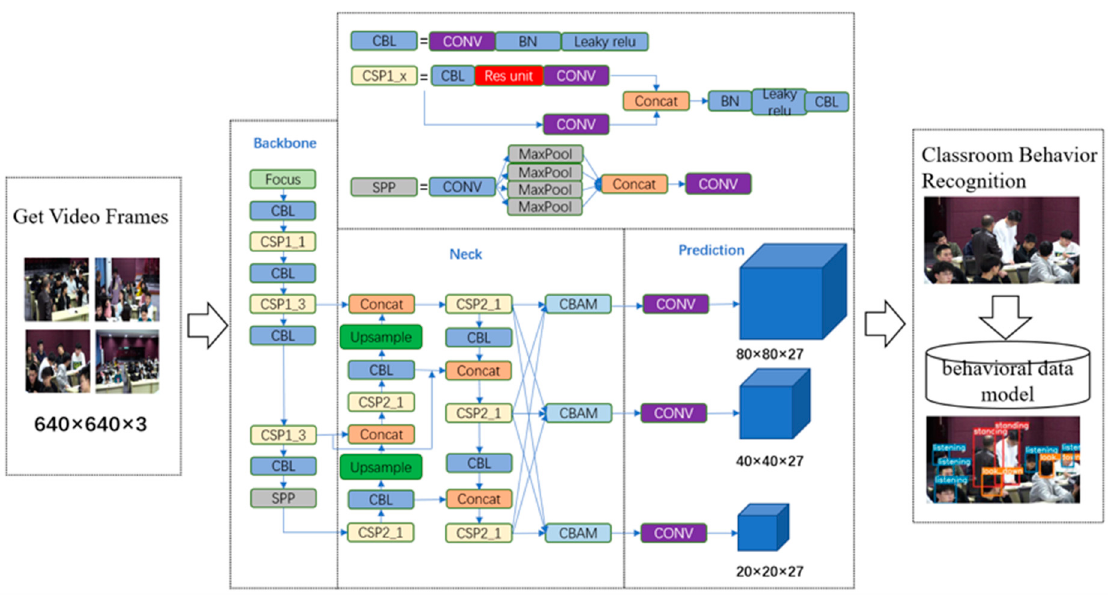
Figure 3. The network structure of the algorithm in this paper.